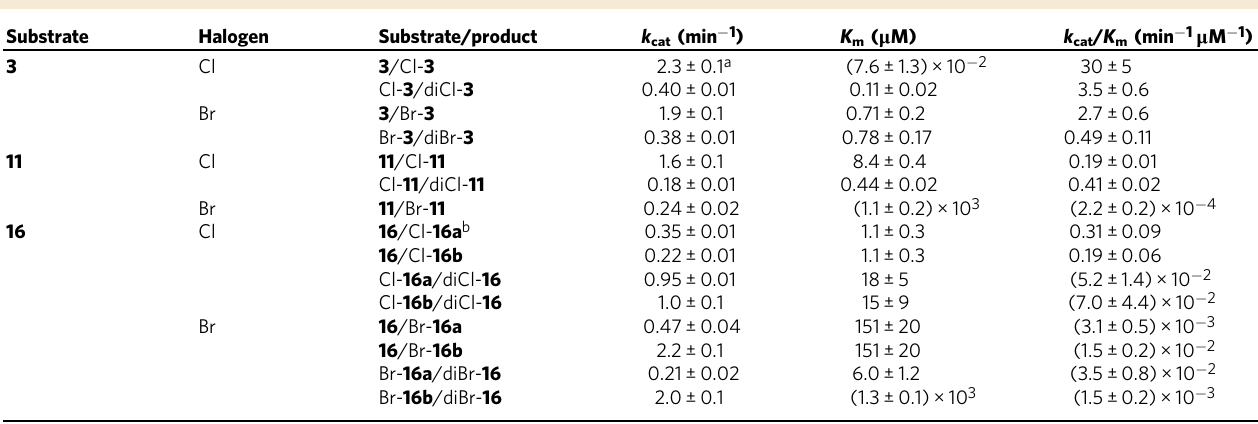
Table 1 Kinetic parameters for halogenations of selected substrates Substrate